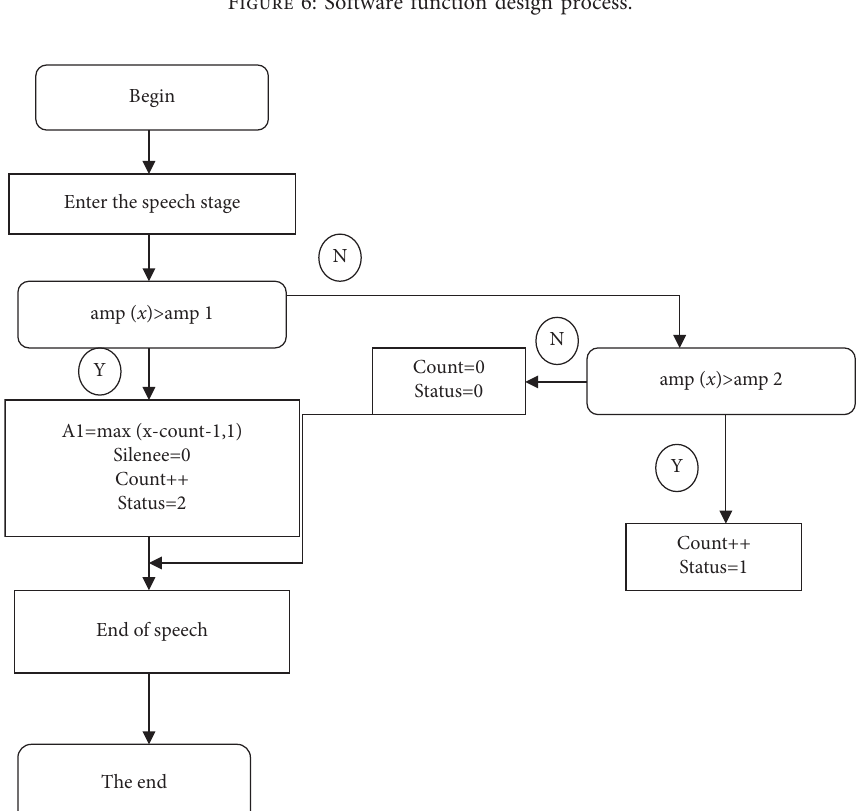
Figure 7: Process of the processing